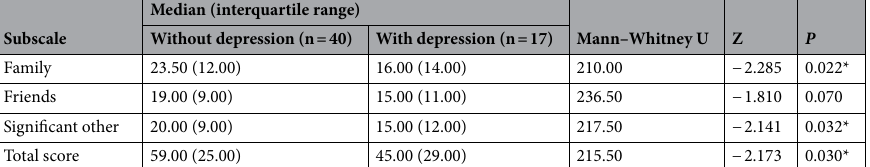
Median (interquartile range)